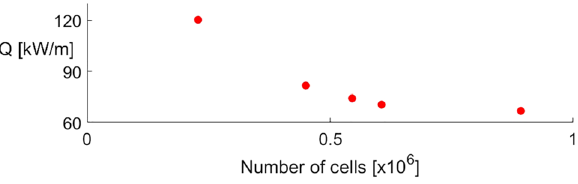
Figure 3. Thermal load evolution with respect to the number of cells for the different grids studied for the case with cooling injection.